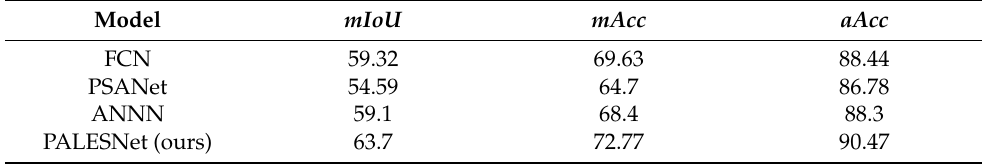
Table 3. The average performance of the different segmentation CNNs on the HCSV